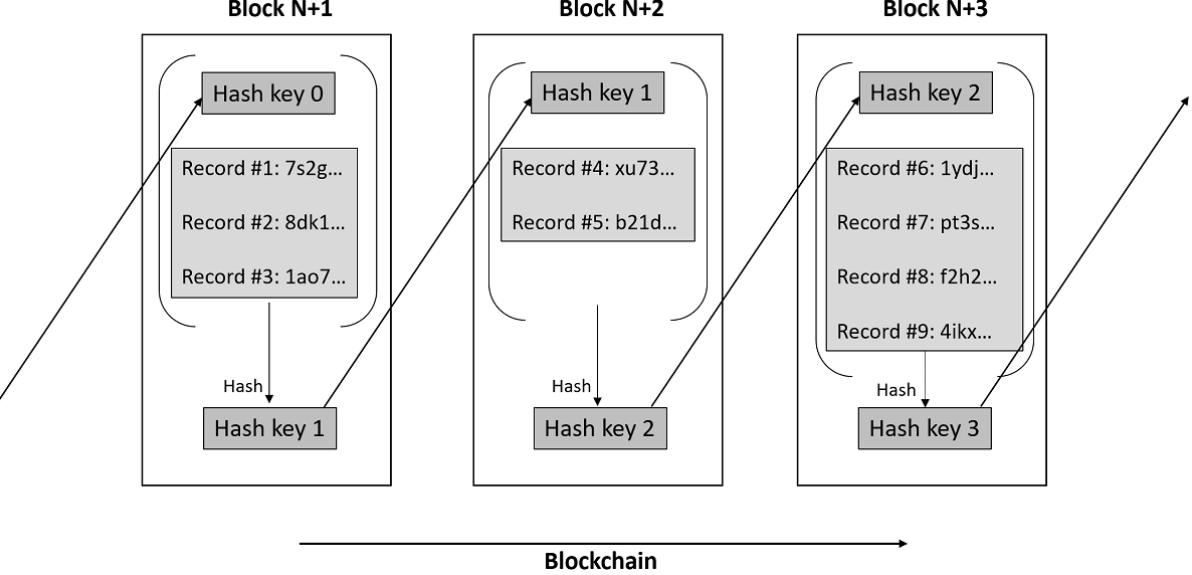
Figure 1. Illustration of how blocks of data are linked together in a blockchain through hashing. To add a new record (eg, Record #7) to the blockchain, this is first grouped with other records (Records #6, #8, and #9). The group of records is then combined with a hash key from the previous block (hash key 2) and then put through a hashing algorithm to produce a new hash key (hash key 3). The new records, along with hash keys 2 and 3, are now part of a new block (Block N+3) that has been added to the blockchain. This process continues as new records are